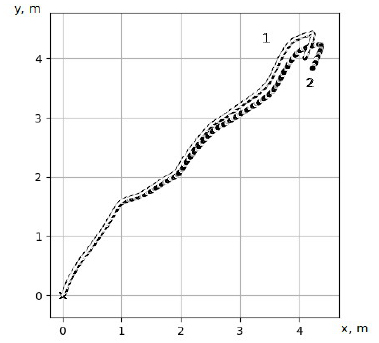
Fig. 8. The actual (1) vs predicted (2) trajectory of the robot, using the predicted sensor data from the stacked LSTM model (prediction length of 600).